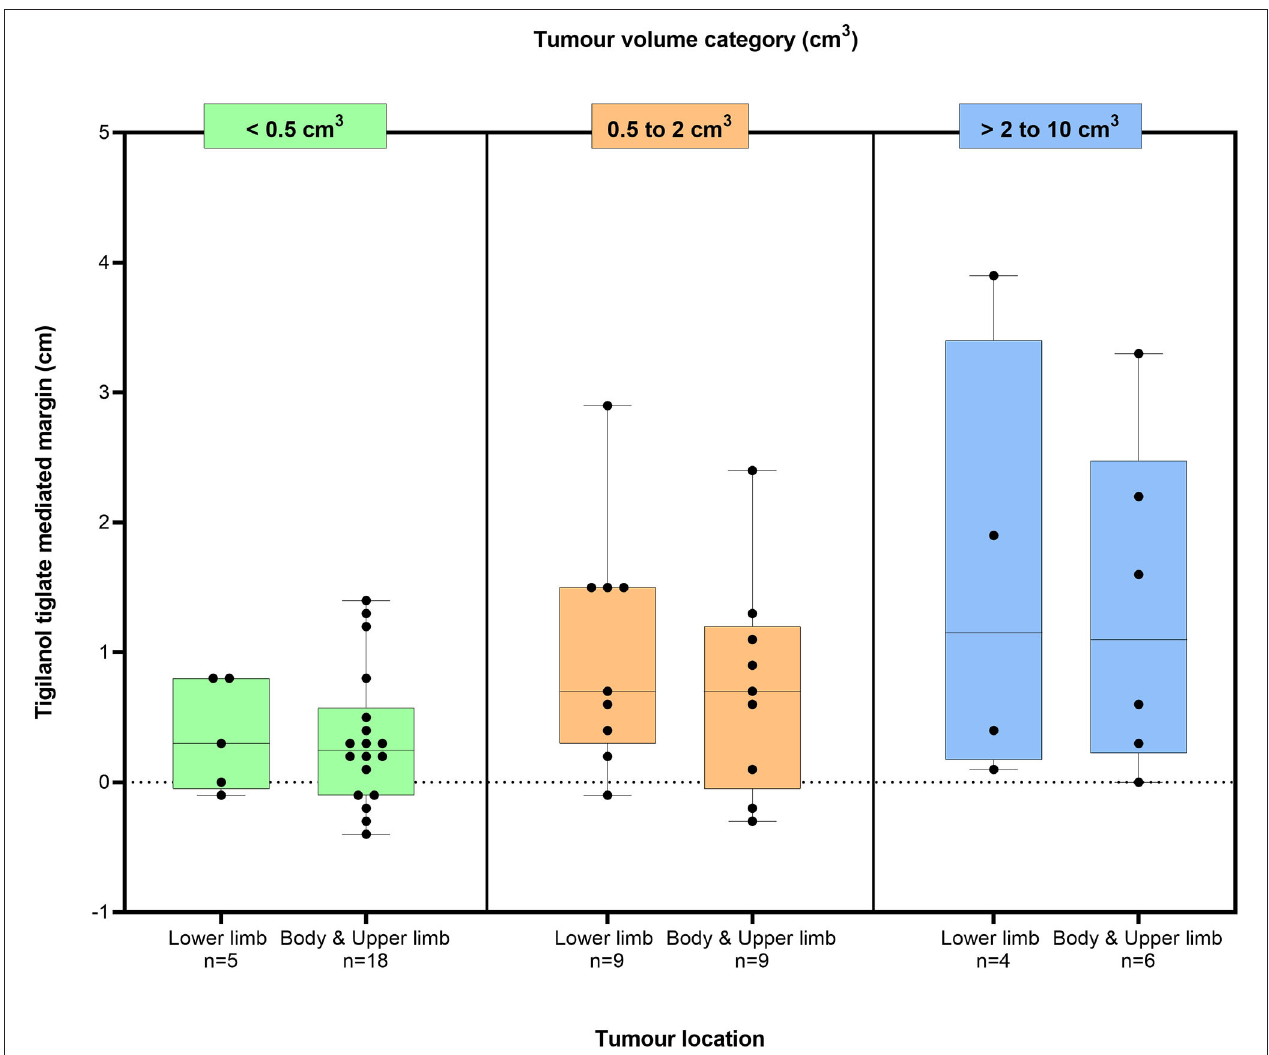
FIGURE 3 | Box plots of the estimated TT-mediated margins summarised by two body locations in three tumour volume classes for 51 dogs that were recurrence free 12 months after a single intratumoural treatment of an MCT with TT. Boxes in the plot represent the 25th, 50th, and 75th percentiles; whiskers show the maximum and minimum values with the dots indicating the 51 individual data points. Values of p calculated using Mood’s median test of body location for each tumour within each tumour volume class were 0.9, 1.0, and 1.0,